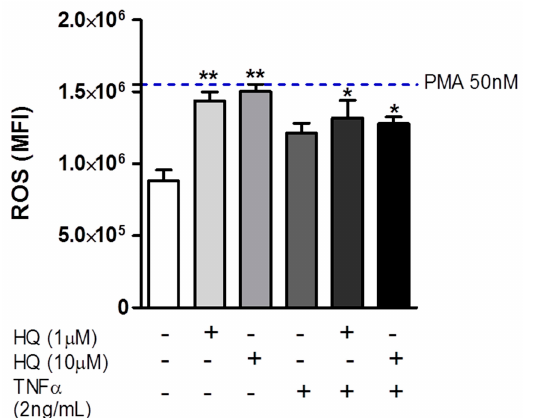
Figure 4. In vitro HQ treatment enhances the ROS generation by RAHFLS. RAHFLS (1 × 10 4 cells) were incubated with culture medium or HQ (1 or 10 µ M) with or without TNF- α (2 ng/mL) for 24 h. ROS was quantified in synoviocytes using DCFH-DA assay. Data represent mean ± SEM from three independent experiments and were analyzed by one-way ANOVA. * p < 0.05 and ** p < 0.01 vs. culture